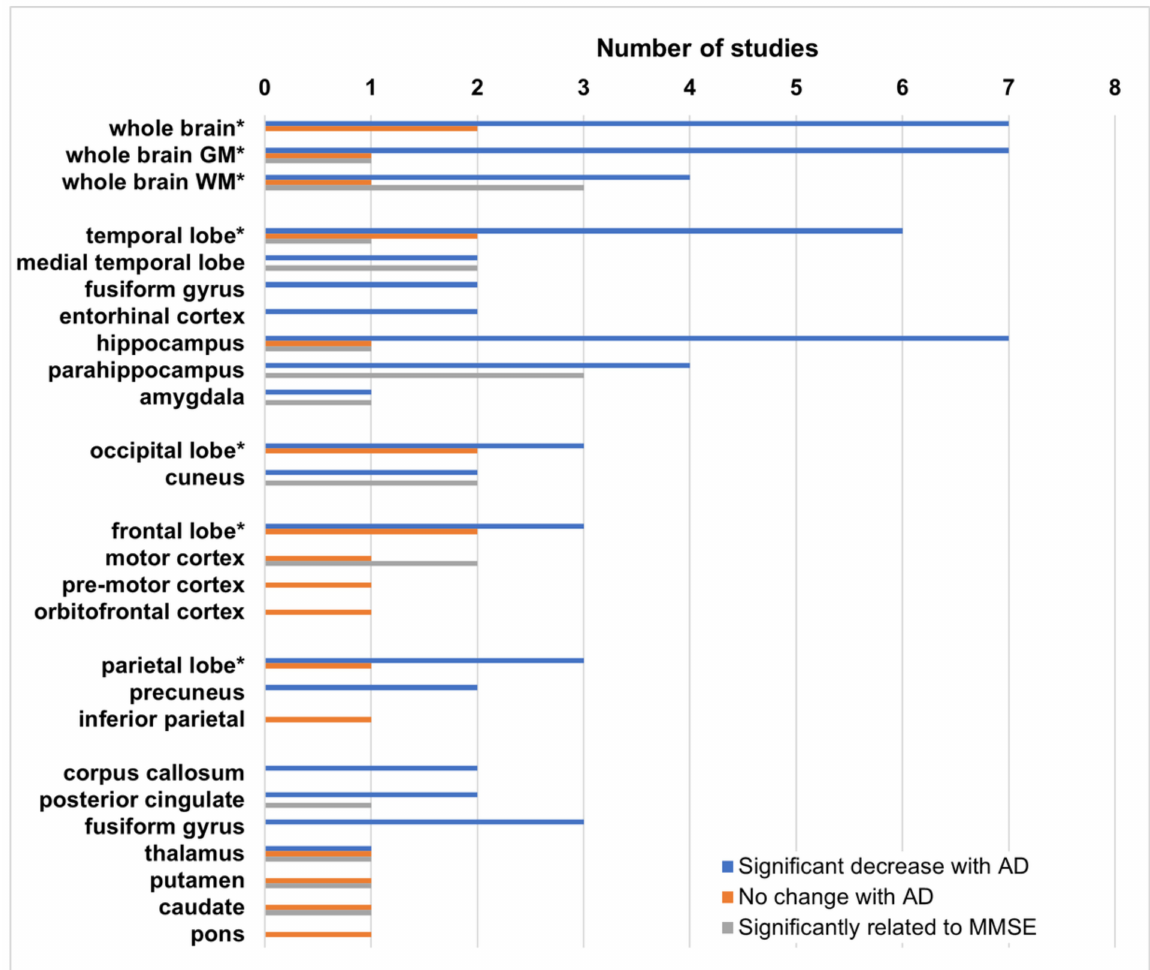
Figure 1. Studies report significant decreases in magnetization transfer ratio (MTR) and/or histogram peak height related to Alzheimer’s disease (AD) and mini-mental state examination (MMSE) in a variety of different brain regions, most of which are included in this figure. For the two studies which have analyzed only mild cognitive impairment (MCI) subjects, significant decreases in MTR vs. controls are also included. (* numbers include both MTR and histogram peak heights. Peak heights are more sensitive to changes, and some studies report both a significant decrease in peak height and non-significant change in MTR in the same region). GM—gray matter; WM—white